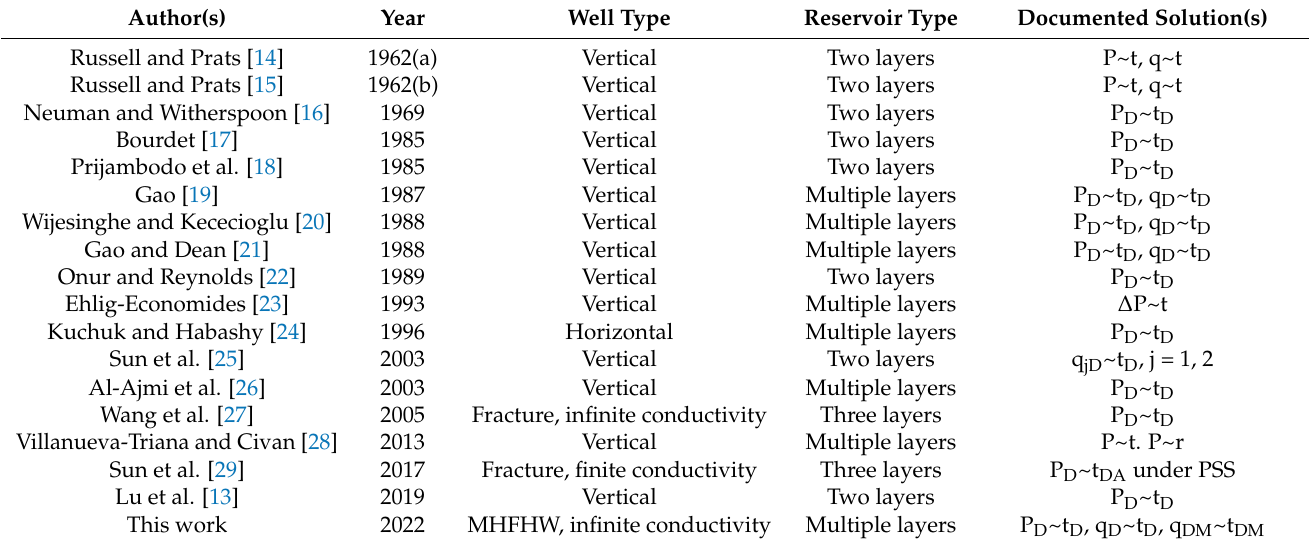
Table 1. Literature regarding multilayered reservoir modeling with crossflow